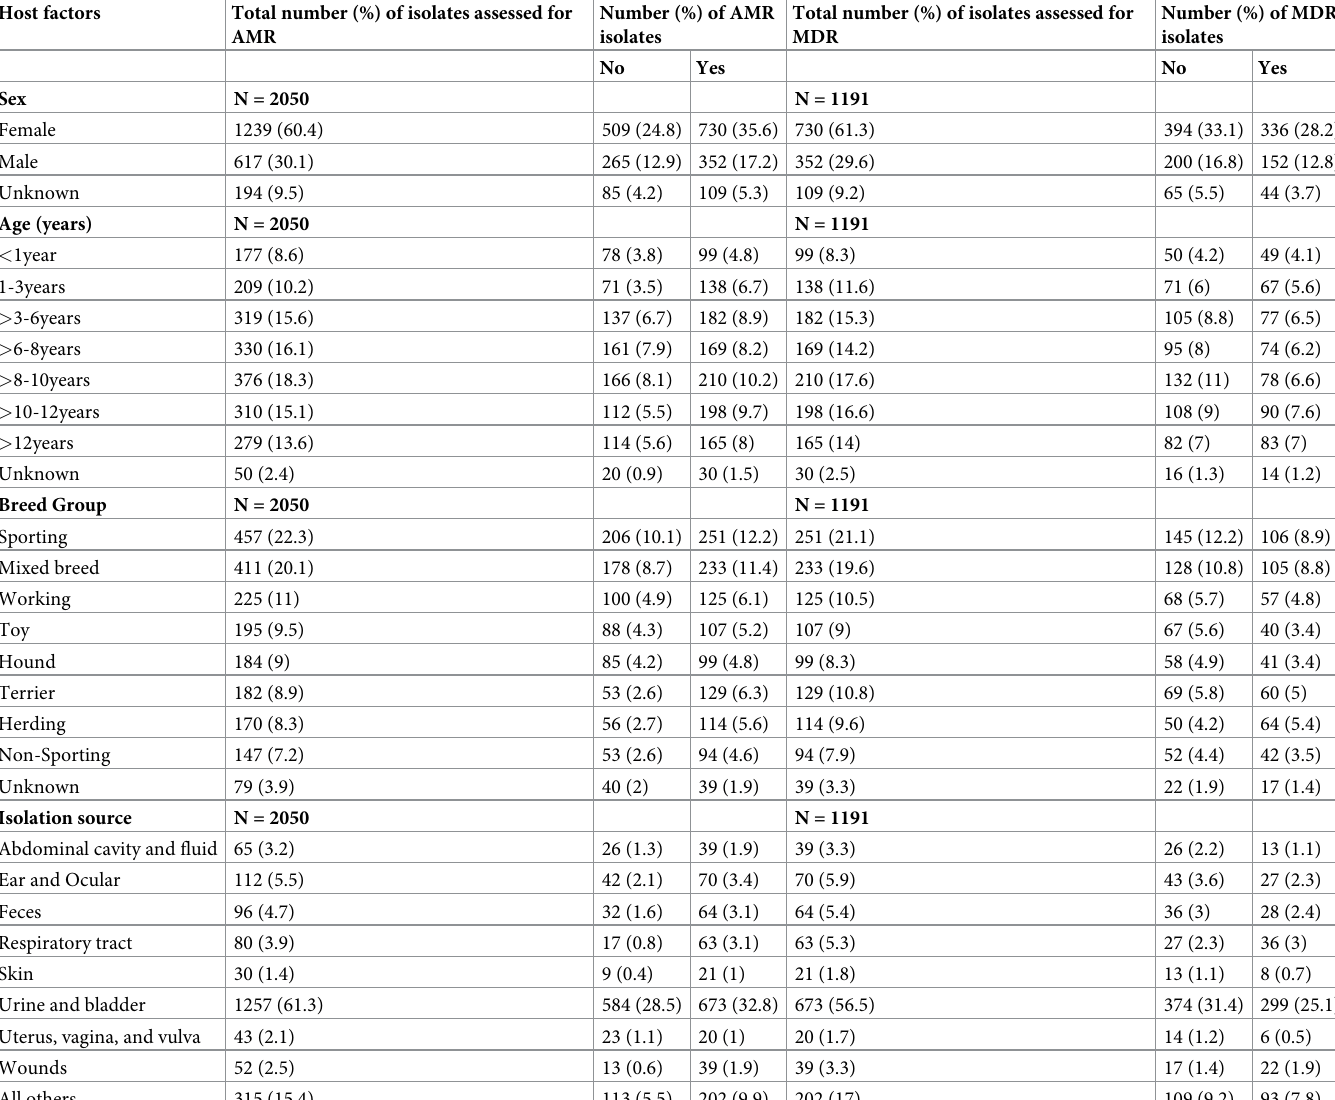
Table 4. The distribution of isolates from Indiana based on host factors and AMR